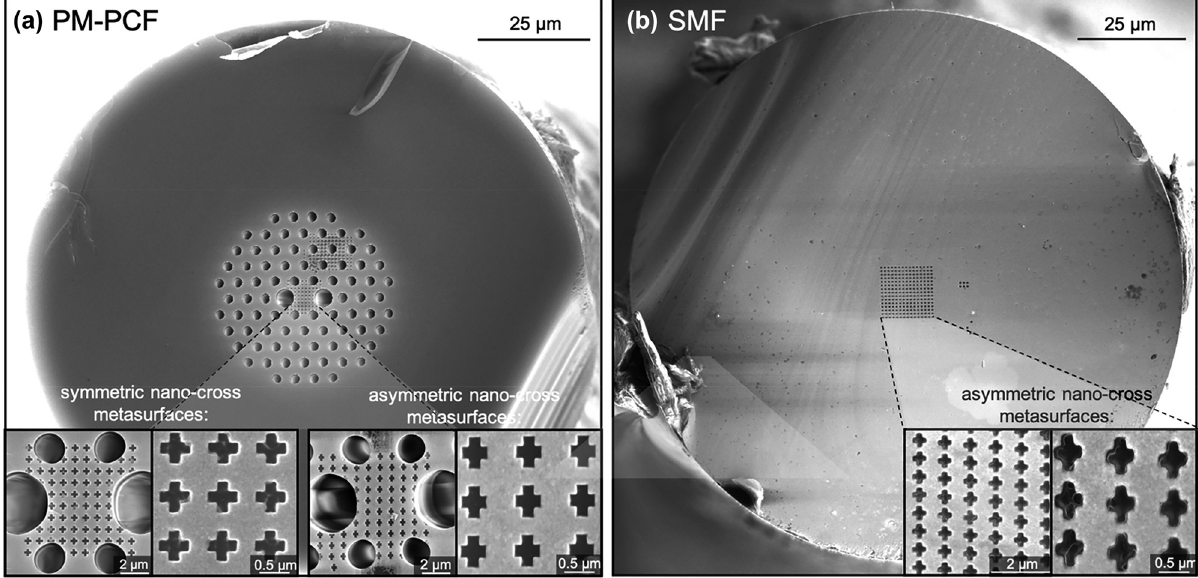
Figure 3: Scanning electron microscopic images of optical fiber metasurface optical filter. SEM images of (a) PM-PCFs with symmetric and asymmetric nanocross metasurfaces fabricated in the rectangular core and (b) conventional single mode fi ber with asymmetric nanocross metasurfaces fabricated in the circular